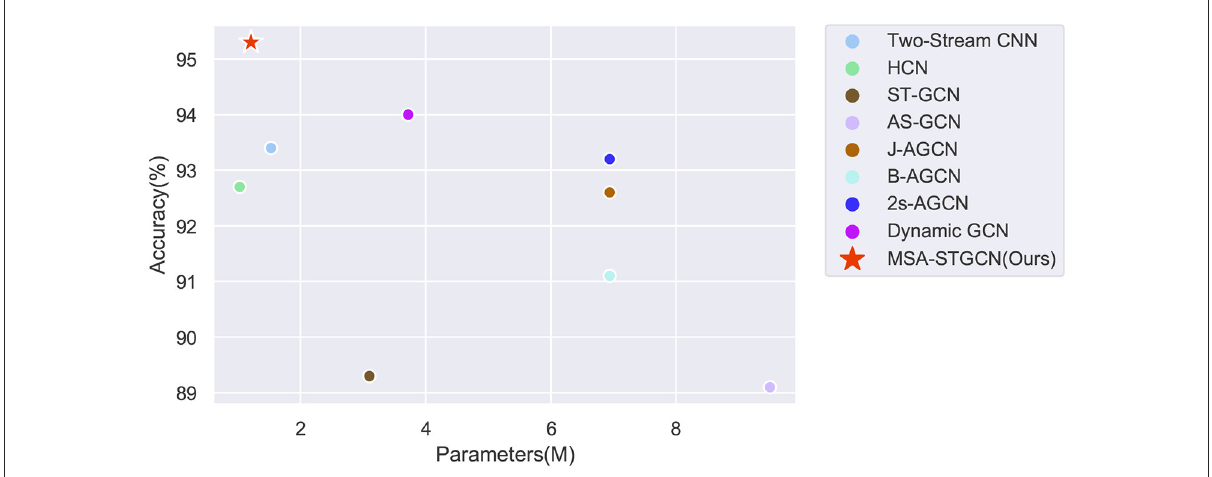
FIGURE6 The accuracy and parameters of the proposed method compared to other methods on the Filter NTU RGB+D dataset.